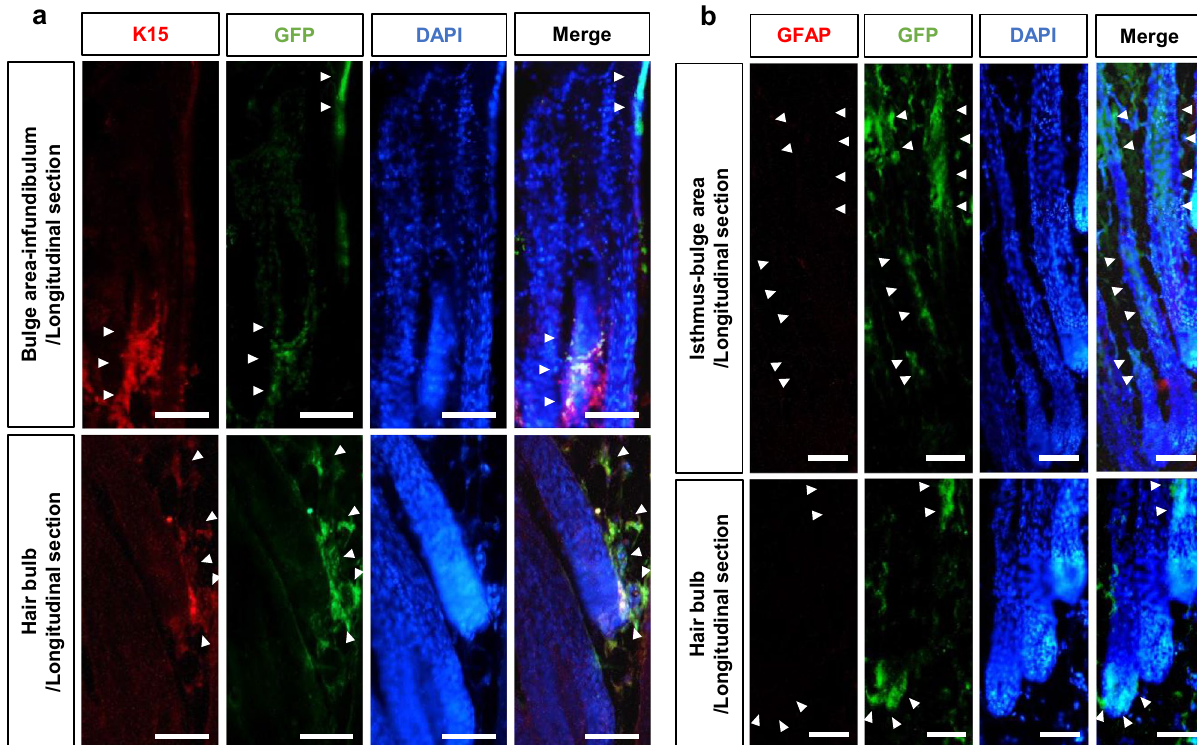
Figure 5. Characteristics of the isthmus, infundibulum and hair bulb stained with GFP and K15 or GFAP of nude-mouse pelage follicle after transplantation of the upper part of whisker follicles from ND-GFP mice. ( a ) Longitudinal section stained with K15 and GFAP of the bulge area and infundibulum (upper row), and hair bulb (lower row) of nude-mouse pelage follicle in the mice transplanted with upper part of whisker follicles from ND-GFP mice. ( b ) Longitudinal section stained with GFP and GFAP of the isthmus and bulge area (upper row), and hair bulb (lower row) of nude-mouse pelage follicle in the transplanted mice. Scale bar = 50 µm. White arrowheads indicate the HAP stem cells which jumped to the pelage